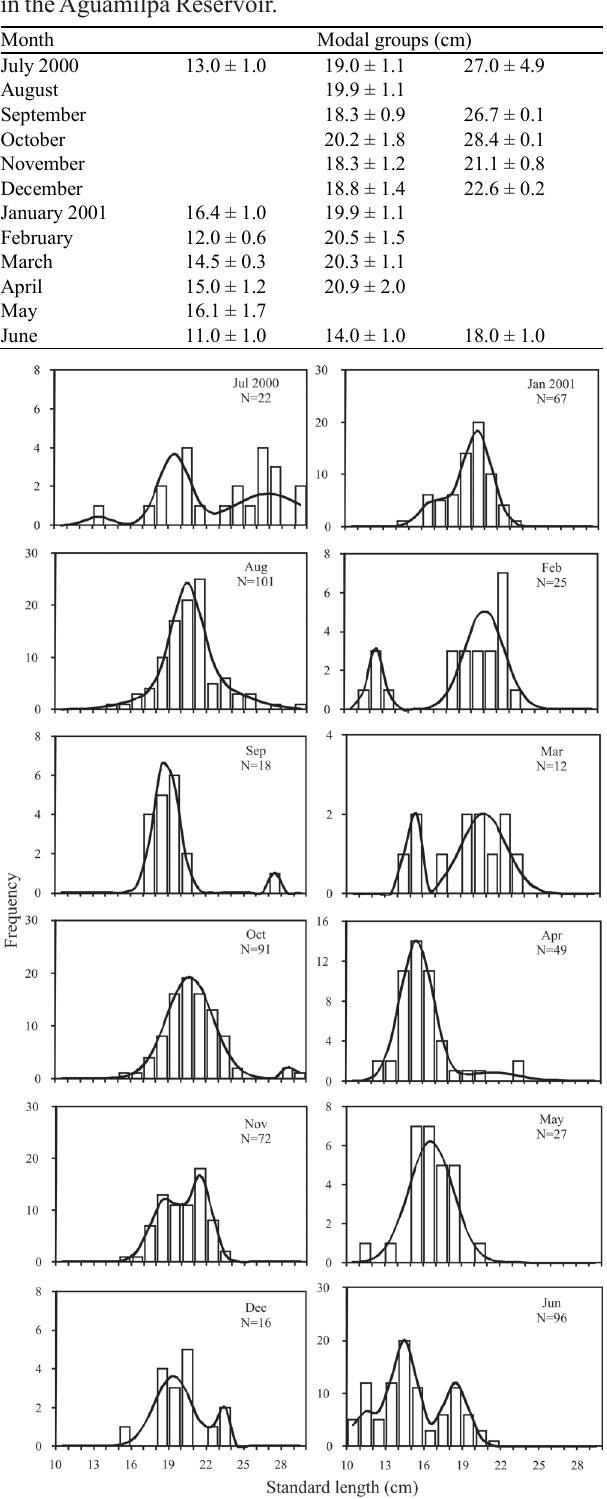
Fig. 3. Monthly frequency distribution of size and modal groups of Sinaloa cichlid Cichlasoma beani in the Aguamilpa Reservoir in Nayarit, Mexico.